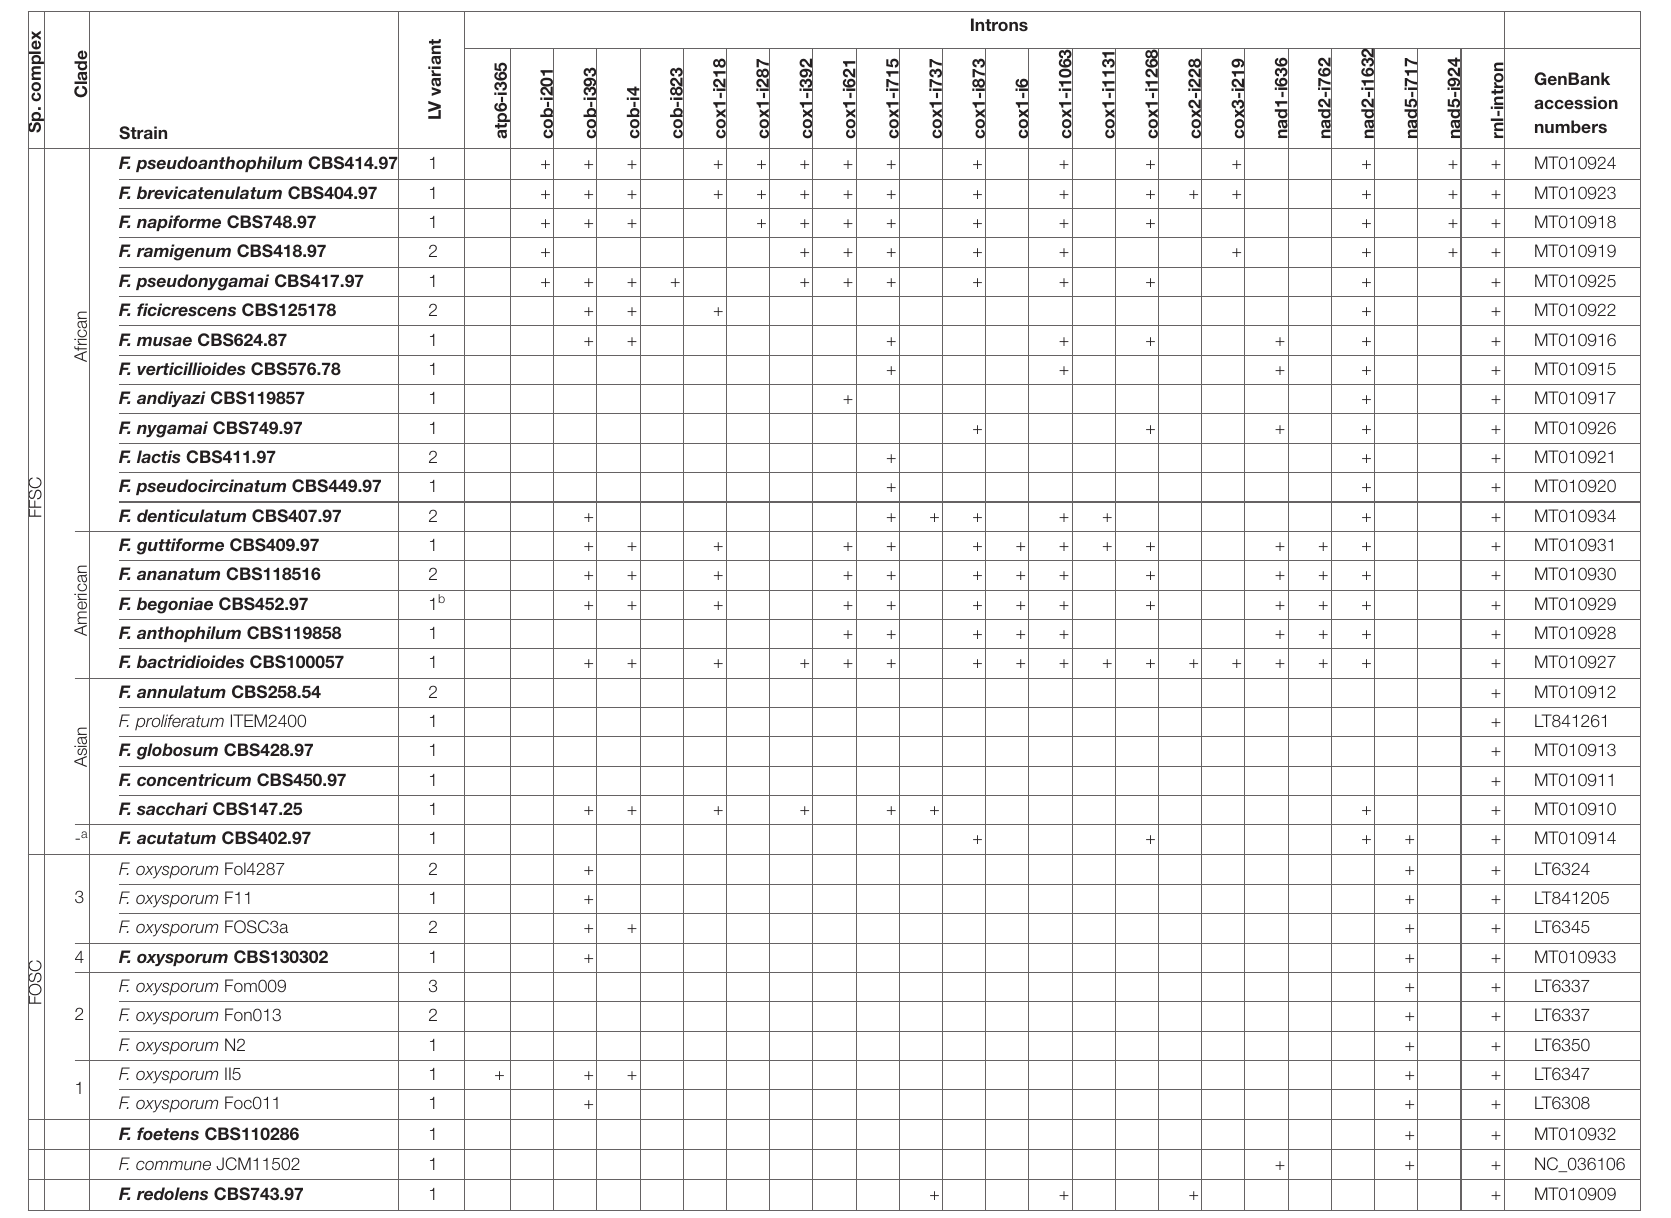
TABLE 1 | LV variant and intron presence in the analyzed